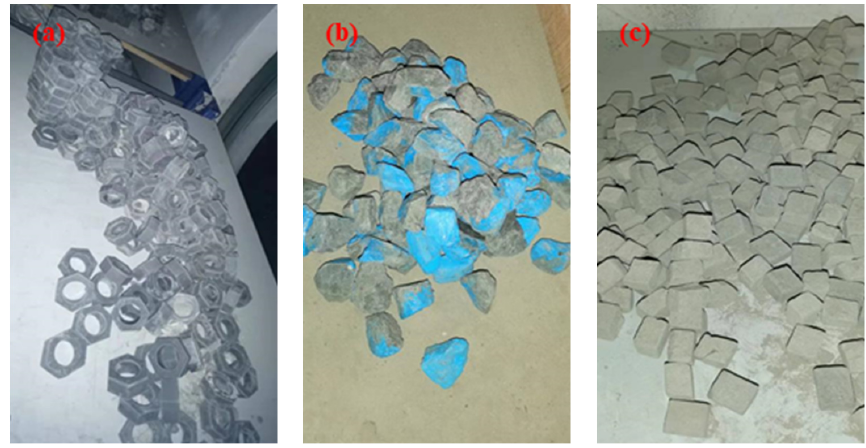
Figure 5. Different fillers (( a ) filler A; ( b ) filler B; ( c ) filler C).